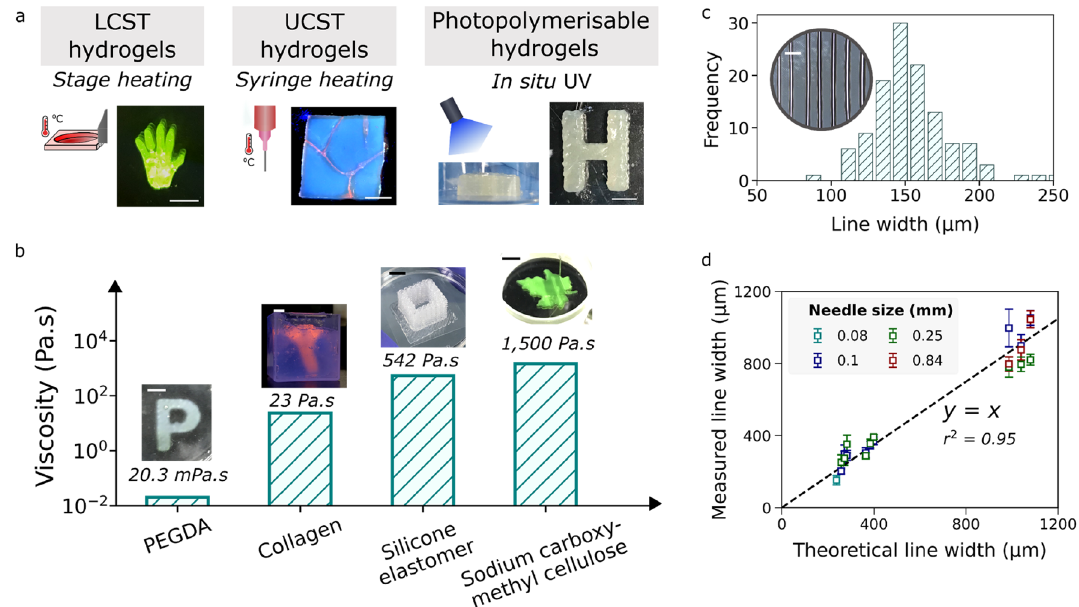
Figure 2. ( a ) Figure showing the use of different auxiliary tools for assisting the printing of LCST hydrogels (e.g. Pluronic F127), UCST hydrogels (e.g. gelatin), and photopolymerizable hydrogels (e.g. methacrylate hydroxypropyl cellulose). ( b ) A wide variety of materials over a large viscosity range can be printed using the setup. ( c ) Distribution of the line width of the printed Pluronic F127 filaments fabricated using a 34G needle, an extrusion flow of 825 μL/h and a stage speed of 5 mm/s. Median line width = ~ 150 μm. ( n = 120 measurements over 4 independent samples). ( d ) Figure comparing the theoretical line width and the measured line width ( n ≥ 20) obtained when different print parameters were used (i.e. stage speed, extrusion flow and needle size). The experiments were performed with Pluronic F127 at over-extrusion condition, where theoretical line width resulting from the printing setting is larger than the needle size. The deviation of the points from the identity line (y = x, shown as black line) indicates the discrepancy between the measured and the theoretical line widths. Scale bars in ( a ) and ( b ) = 5 mm. Scale bar in ( c ) = 500